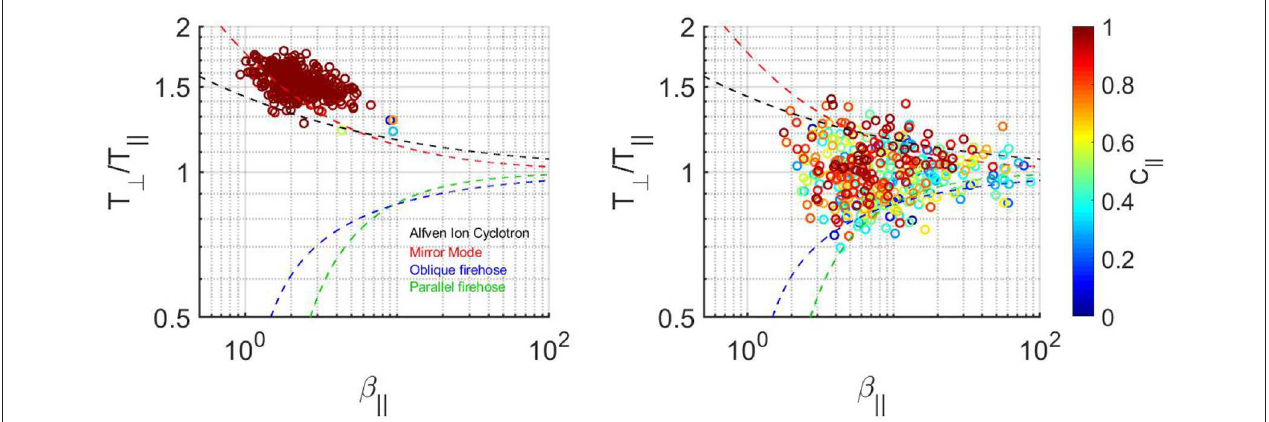
FIGURE 6 | (Left) Parallel compresibility C || (color code) as a function of proton temperature anisotropy and parallel plasma beta β || for the Q ⊥ MSH; (Right) Same as on the left for the Q || MSH. The thresholds for the different plasma instabilites are shown with dashed lines in